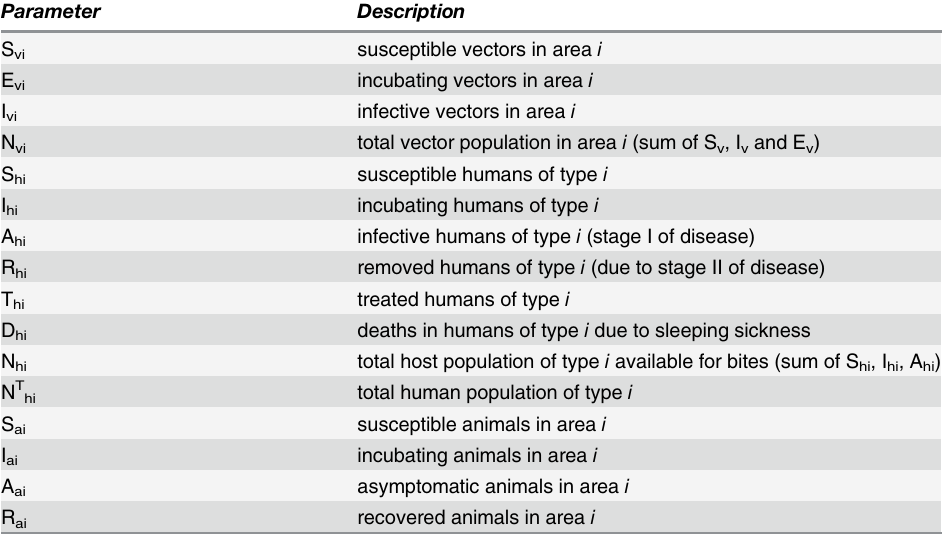
Table 1. Description of state parameters where i is 1 or